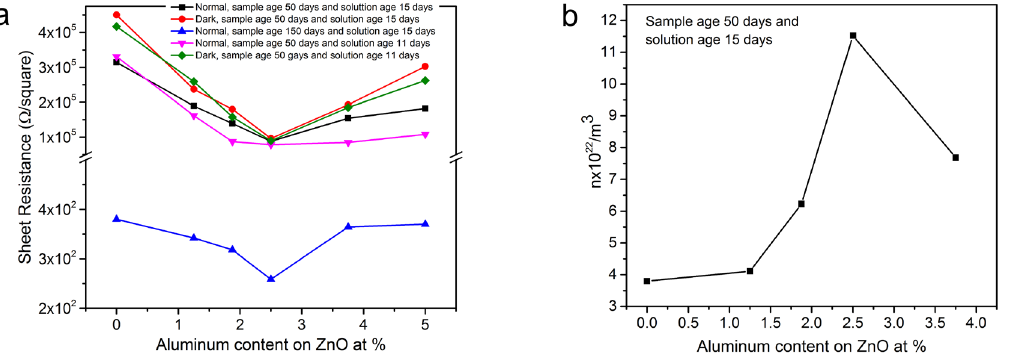
Fig. 1(a) Effect of different aluminum content on electrical sheet resistance of ZnO : Al thin films prepared with different solution age and sample age, (b) Effect of aluminum content on carrier concentration of ZnO : Al thin films with sample age 50 days and solution age 15 days composites catalyst,